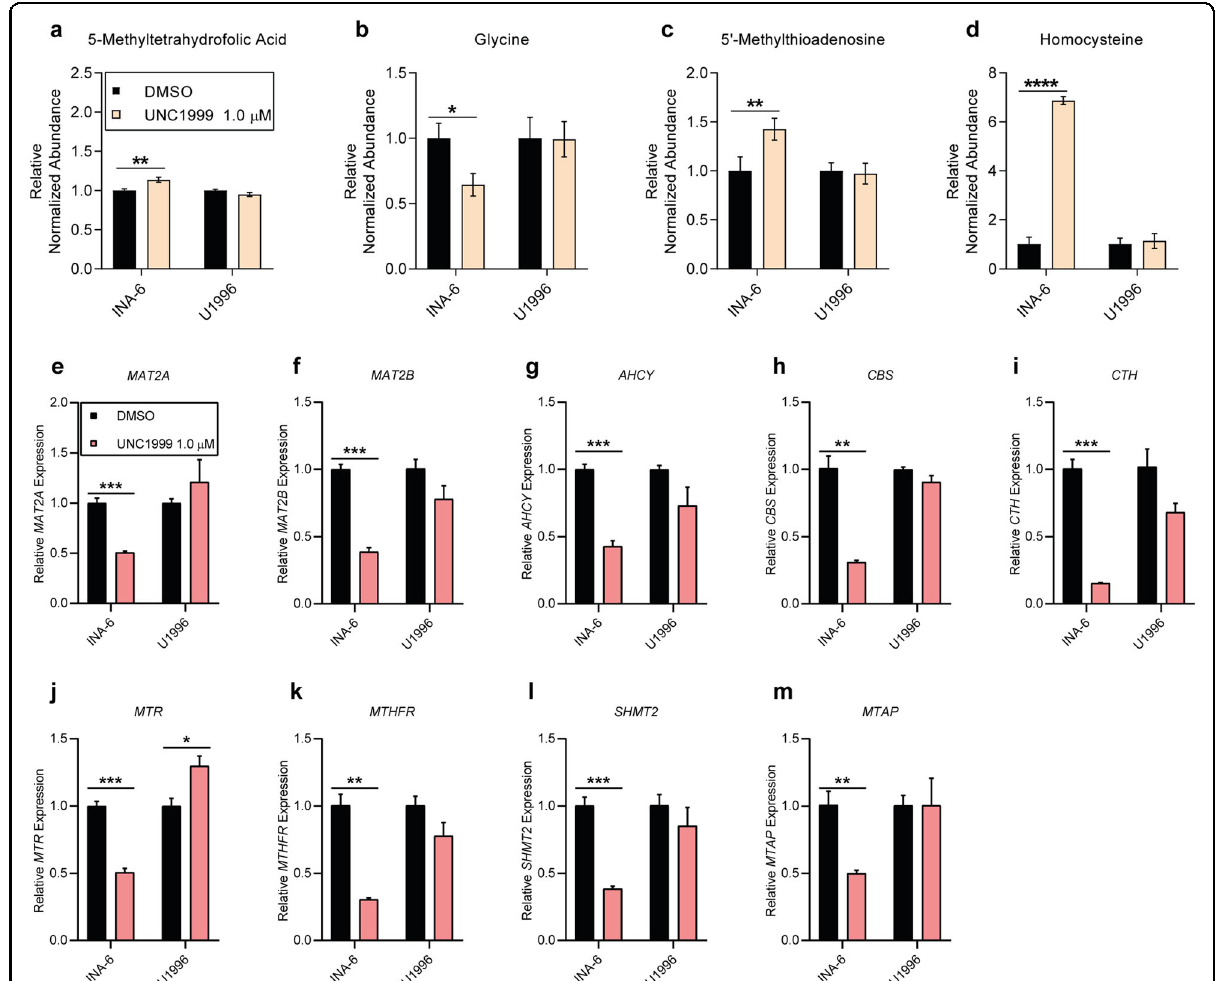
Fig. 3 UNC1999 treatment affected metabolites and genes involved in the methionine cycling pathways. a – d Relative metabolite abundance in INA-6 and U1996 cells after UNC1999 treatment determined by LC-MS for the following metabolites: a 5-methyltetrahydrofolic acid, b glycine, c 5 ′ -methylthioadenosine and d homocysteine. n (DMSO INA-6) = 9, n (UNC1999 INA-6) = 9, n (DMSO U1996) = 11, n (UNC1999 U1996) = 10. e – m Gene expression analysis by RT-qPCR of the following methionine cycling-associated genes in INA-6 and U1996 post UNC1999 treatment: e MAT2A , f MAT2B , g AHCY , h CBS , i CTH , j MTR , k MTHFR , l SHMT2 and m MTAP . Data were collected from three biological replicates. Statistical analysis was performed with multiple t -test. Values: mean with SEM. * p < 0.05, ** p < 0.01, *** p < 0.001, **** p <